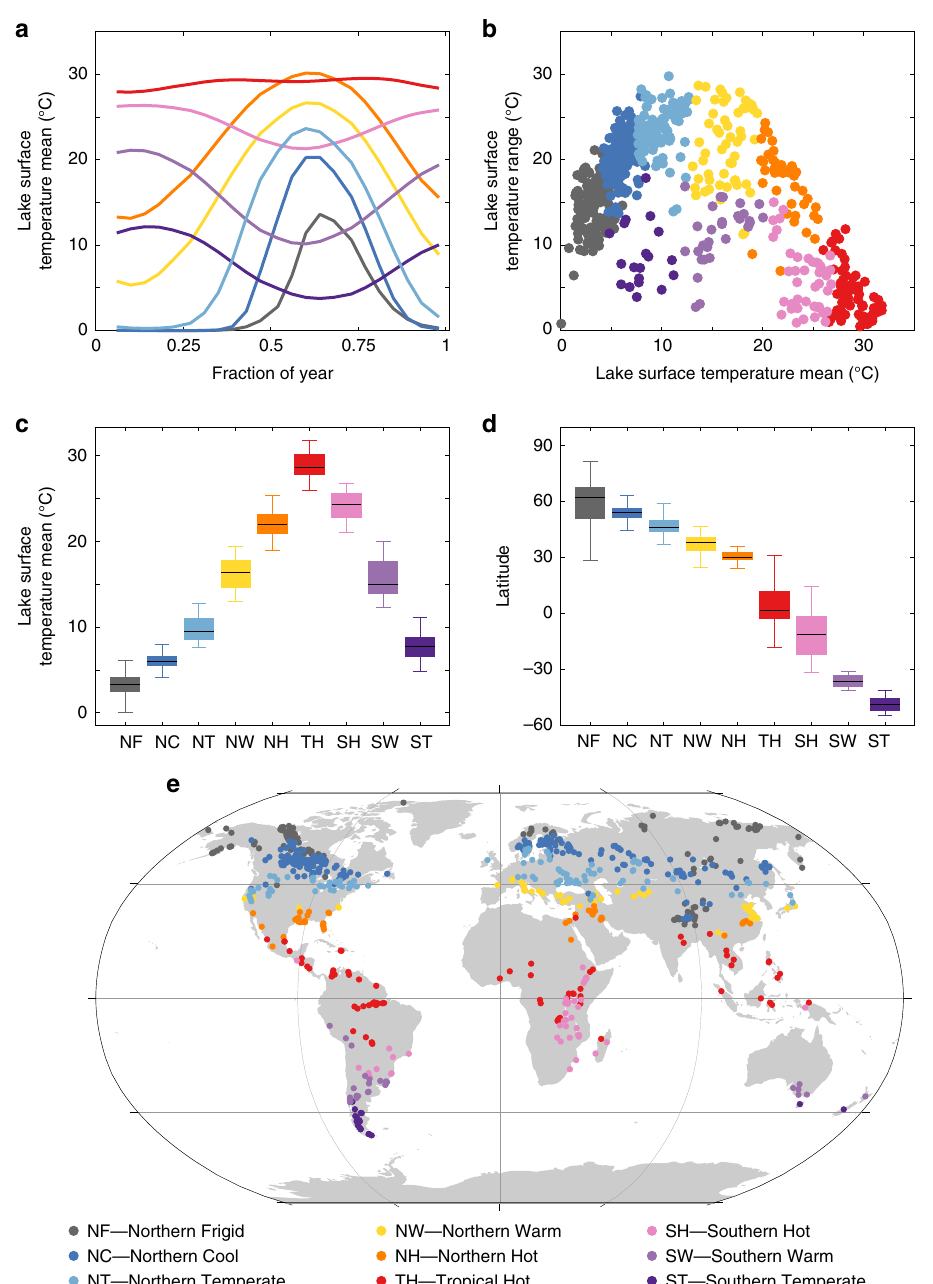
Fig. 1 Allocation of studied lakes to thermal regions. a Mean seasonal satellite-derived lake surface water temperature. b Annual range vs. annual mean for the individual lakes. c Boxplots of temperature in each lake group, the box is the interquartile range, the horizontal line is the median and the whiskers are 1.5 times the interquartile range. d Boxplots of latitude in each lake group. e Map of studied lakes by thermal